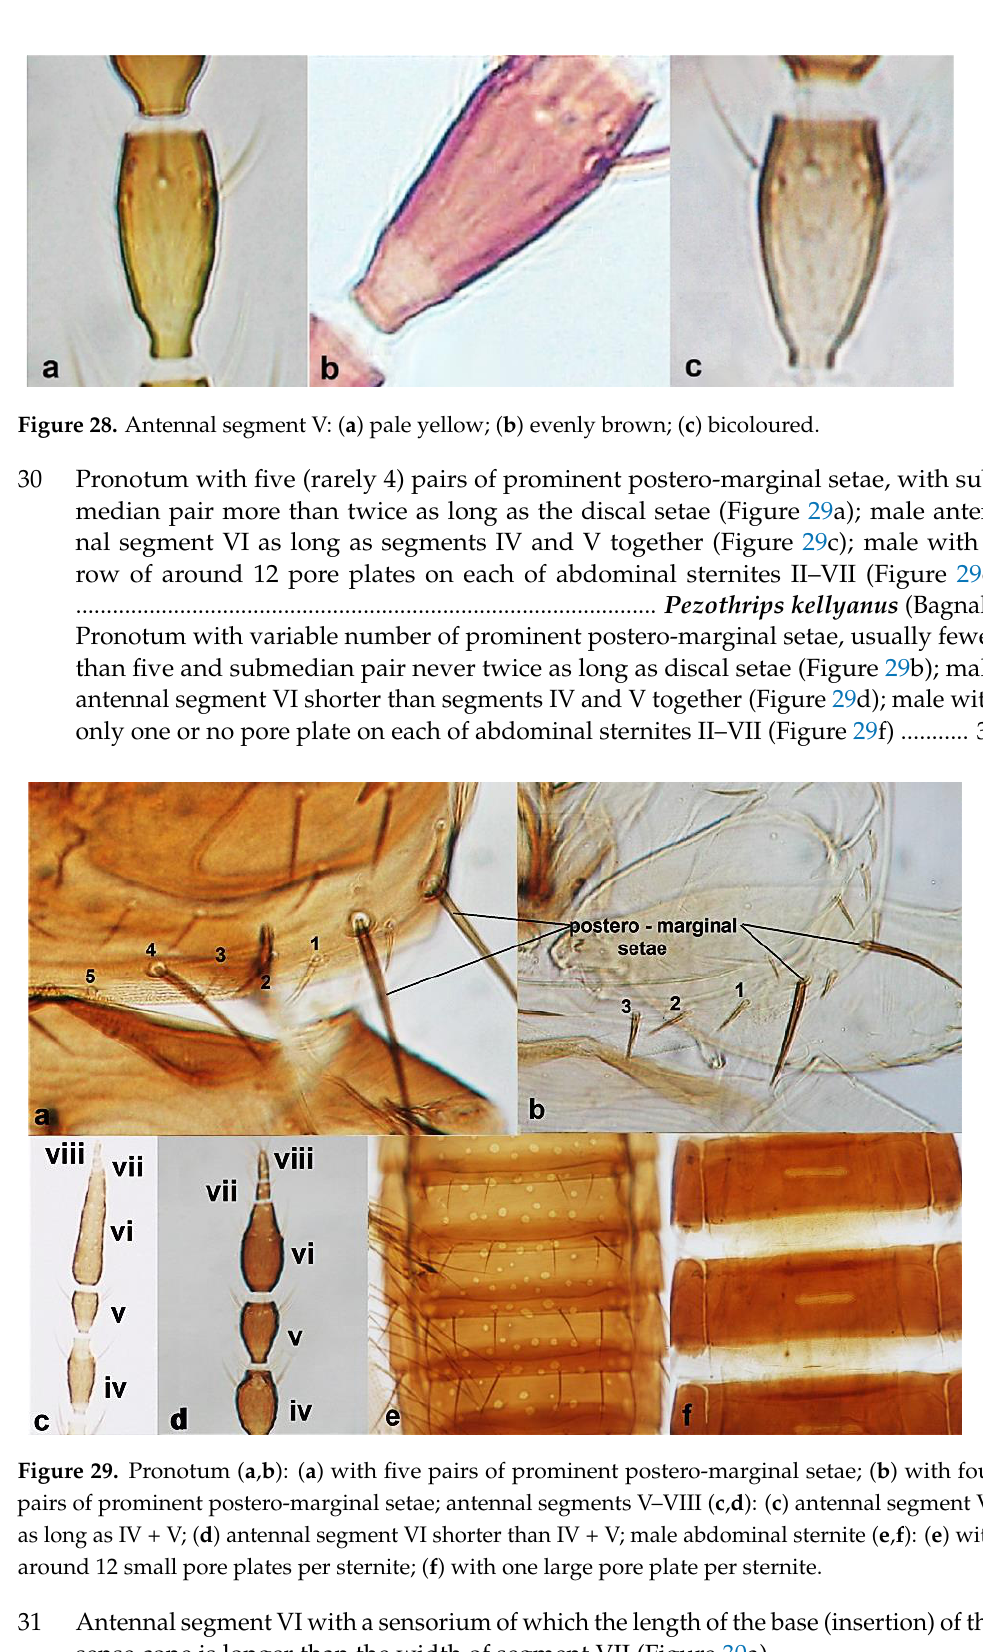
Figure 28. Antennal segment V: ( a ) pale yellow; ( b ) evenly brown; ( c ) bicoloured.